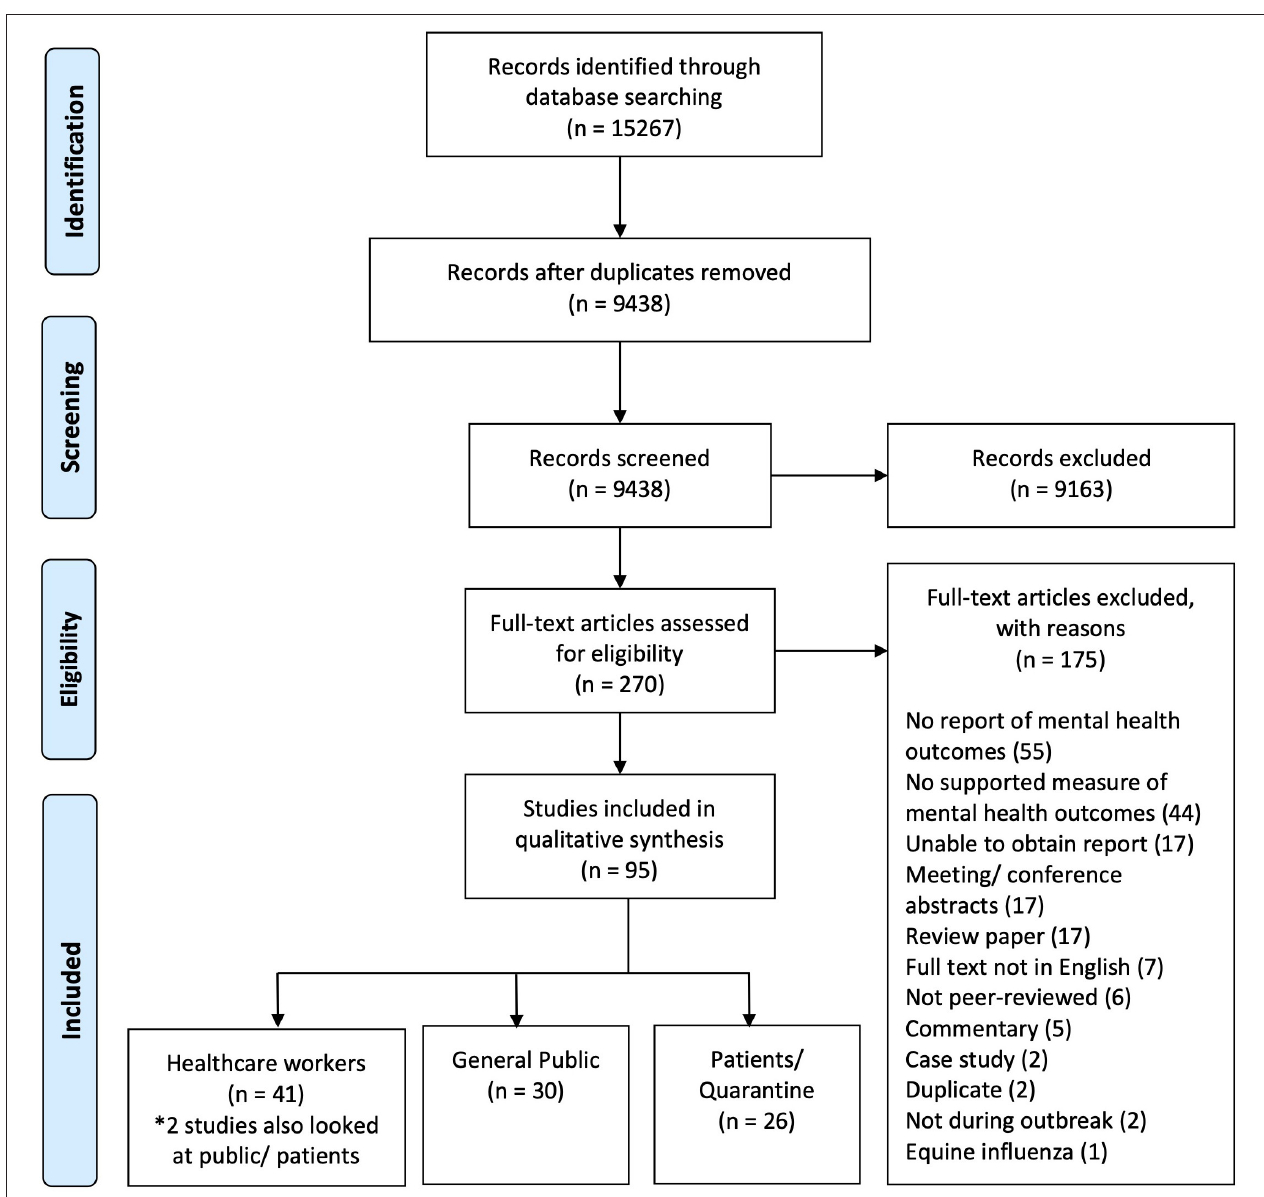
FIGURE 1 | Preferred reporting items for systematic reviews and meta-analyses flow diagram.